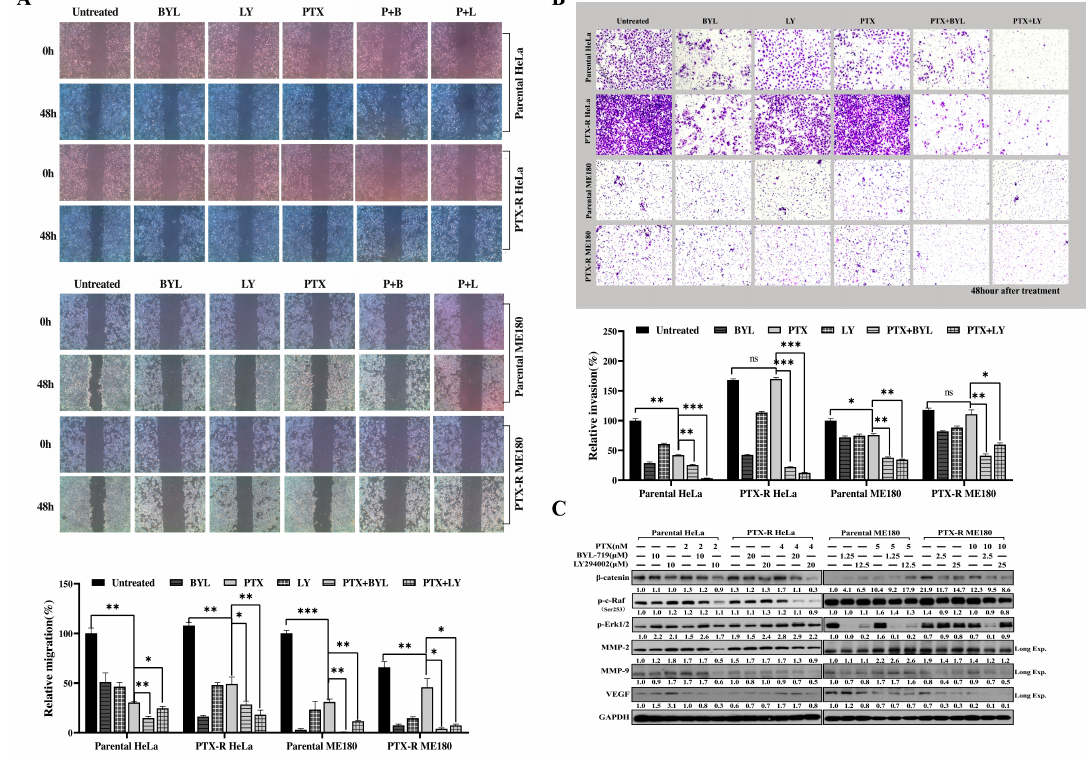
Figure 6. The e ff ects of combined BYL-719 or LY294002 and paclitaxel on migration and invasion in parental and paclitaxel-resistant HeLa and ME180 cells after 48 h. ( A ) Cell migration was observed using a wounding healing migration assay that was quantified by Image J, measuring the wound area at both 0 h and 48 h time points with a mean value of four di ff erent fields per scratch. The data are representative images of three independent experiments. Original magnification, × 100. Column graphs for the quantification of cell migration after various treatments is presented as the mean ± standard deviation (SD); * p < 0.05; ** p < 0.01; *** p < 0.001. ( B ) Cell invasion was determined using a transwell invasion assay. Original magnification, × 200.Quantification of the number of invading cells is presented as the mean ± SD of three experiments; * p < 0.05; ** p < 0.01; *** p < 0.001. ( C ) The representative western blots (mean value is presented below the bands from three independent experiments) of migration and invasion molecular pathways related to β -catenin, p–c-raf, p-extracellular signal regulated kinase (ERK)1 / 2, metalloproteinase (MMP)-9, MMP-2 and vascular endothelial growth factor (VEGF) expression after treatment with a combination of BYL-719 (or LY294002) with paclitaxel or paclitaxel alone in parental and paclitaxel-resistant HeLa and ME180 cells for 48 h.